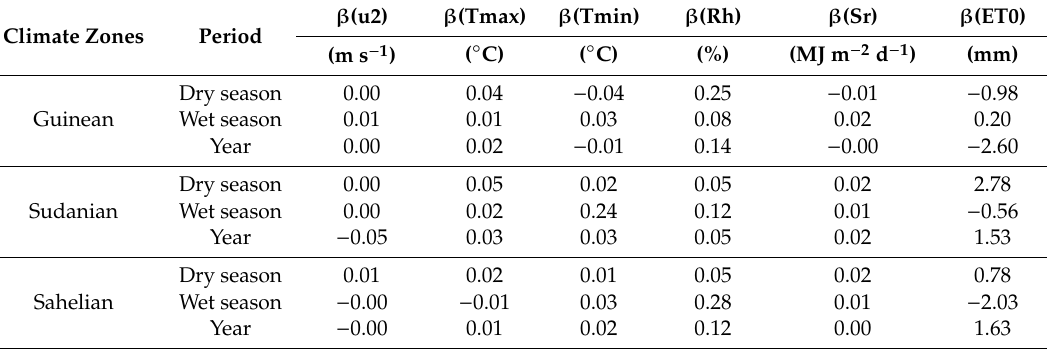
Figure 4. Spatial distribution of annual and seasonal evapotranspiration over 1984 − 2017 (IDW interpolation on a 32 km by 32 km grid). Table 1. Summary of Sen’s slope average values ( β per year) for evapotranspiration and climatic variables: u2 wind speed, Tmax maximum temperature, Tmin minimum temperature, Rh relative humidity, Sr Solar